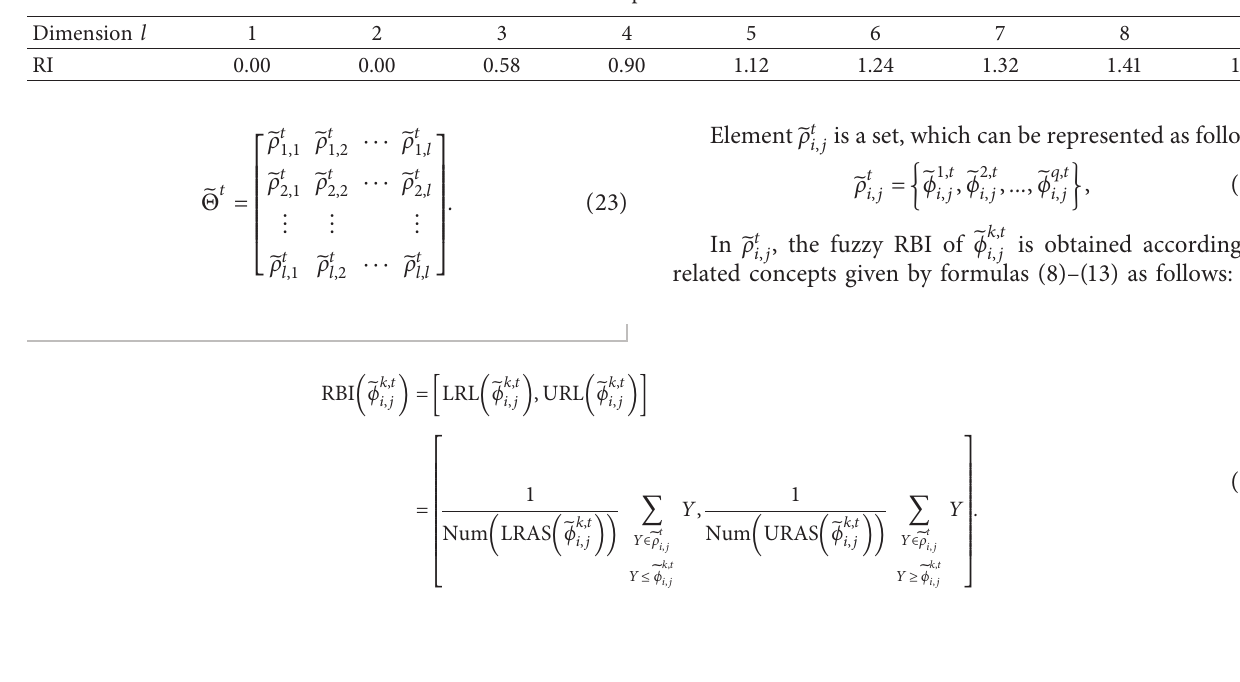
Figure 6: The process of the proposed FRSA-MSWS-PII model. Table 2: The specific value of